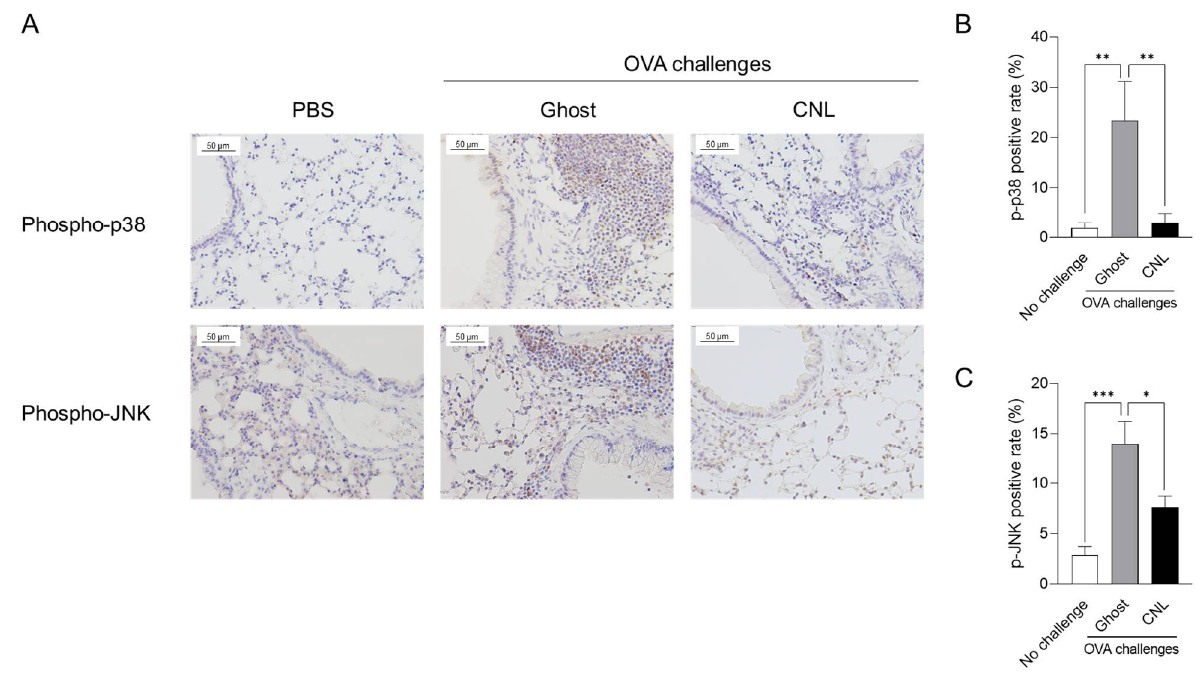
Figure 6. Effects of ceramide nanoliposomes (CNL) on p38 and JNK activation in asthmatic lungs. OVA-sensitized mice were challenged with OVA-free PBS or OVA. OVA-challenged asthmatic mice were treated with 30 μg/animal ceramide-free Ghost or CNL. Lungs isolated from mice were subjected to immunohistochemical analysis using antibodies specific to phospho-p38 and -JNK. Representative images of the immunohistochemistry are shown ( A ). ( B ) Ratio of phospho-p38 positive cells to total cells. Data are shown as mean ± S.E. ( n = 4–5). ** p < 0.01 compared to the Ghost group. ( C ) Phospho-JNK positive cells ratio to total cells. Data are shown as mean ± S.E. ( n = 8–9). * p < 0.05, *** p < 0.001 compared to the Ghost group.